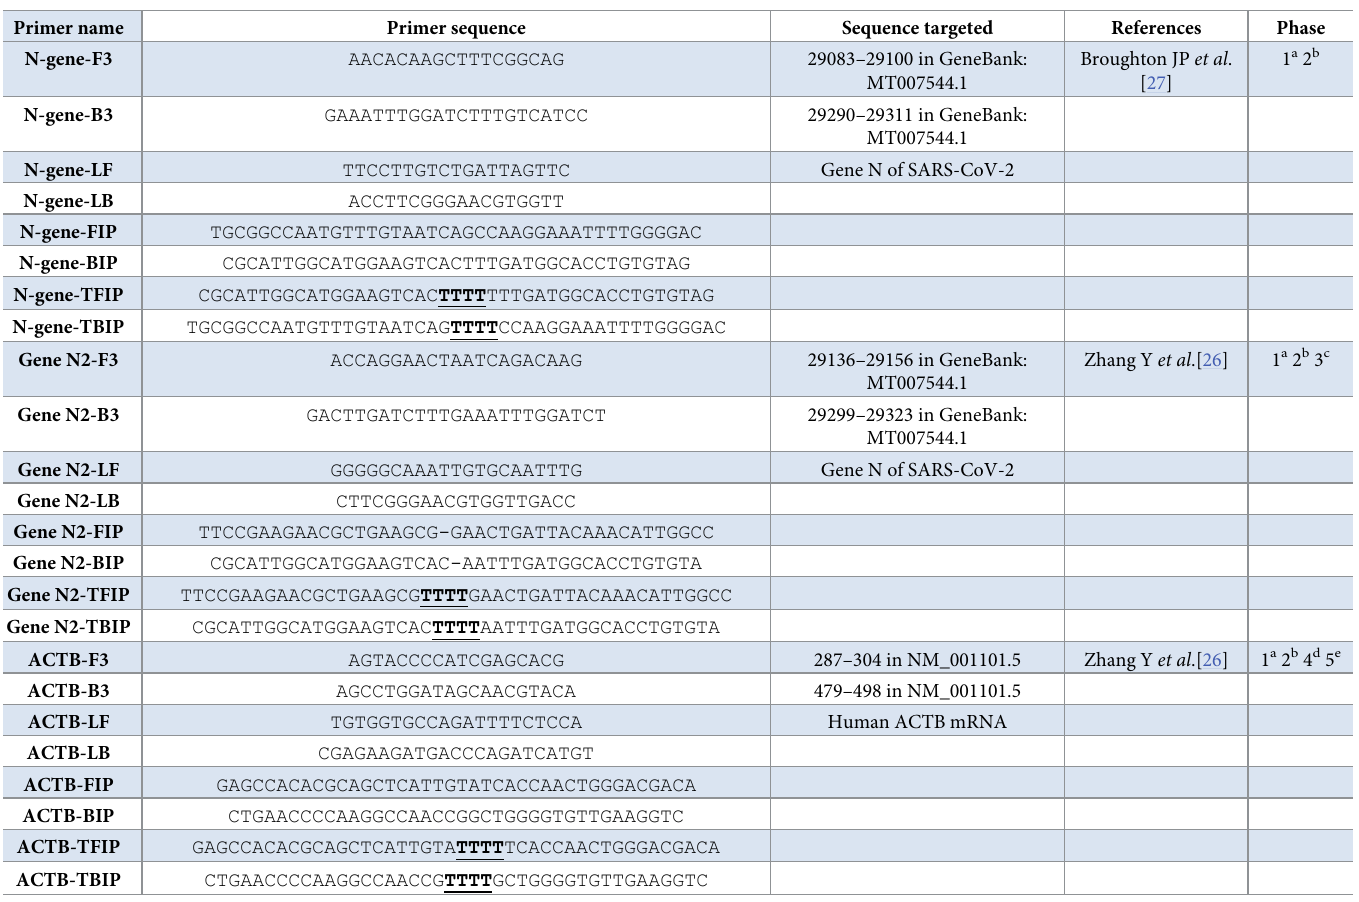
Ecuadorian samples: 21 positive and 21 negative NP swab samples were collected from Feb- ruary to August 2021 in Quito Ecuador. These samples were used to test the optimized RT-LAMP with extracted RNA and raw samples. RNA extraction from clinical NP samples Canadian samples: RNA extraction from clinical NP samples was carried out with miRNeasy Mini Kit (Qiagen, Cat. No. 217004) according to the kit instructions. For all the SARS-CoV-2 positive or negative NP samples, 50 μ l was aliquoted for RNA extraction, and the extracted RNA was eluted out with 50 μ l DNase/RNase free water. Colombian samples: Batch 1: RNA extraction was performed with Quick-RNA viral kit (Zymo, Cat. No. R1035-E). 100 μ l of sample was applied for extraction, and RNA was eluted